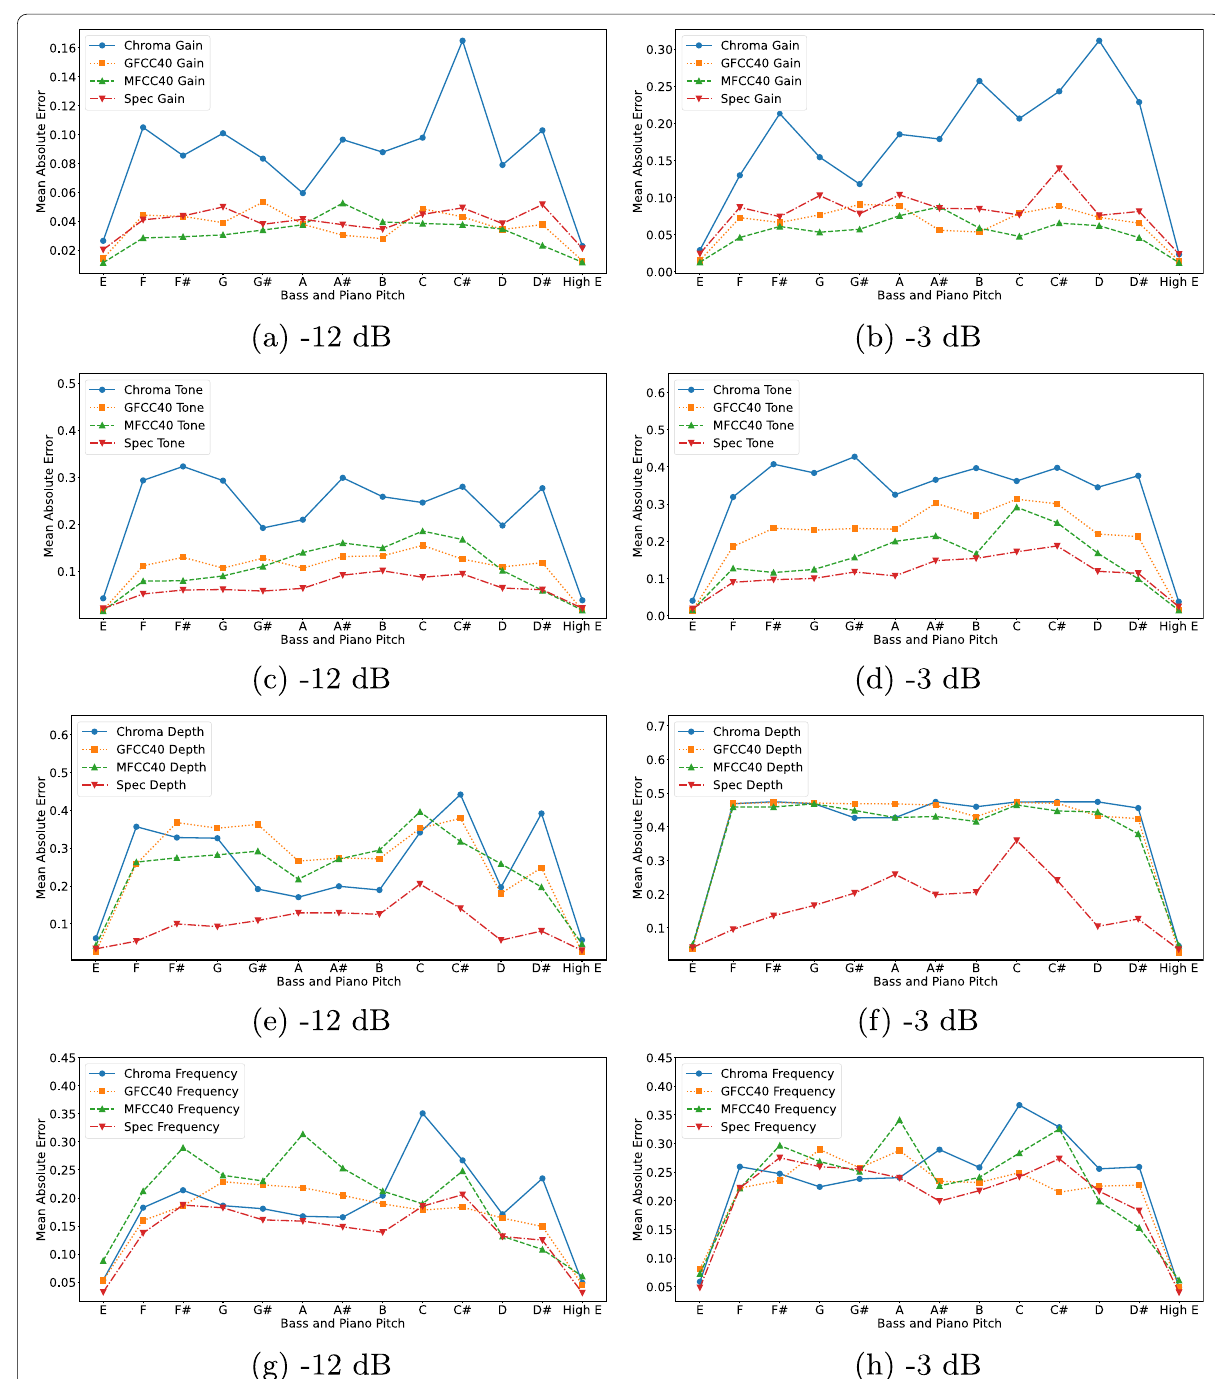
Fig. 14 Mean absolute error of the parameter extraction of the convolutional neural network across pitch of keyboard and bass for all time-frequency representations investigated. Only the two E tones were part of the training. Shown are, respectively, the extraction errors for the gain, tone, depth, and frequency parameter of the distortion and tremolo effect at ( b , d , f , h